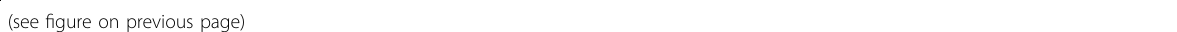
Fig. 2 Aspirin mediated protein deacetylation and autophagy induction in mouse leukocytes. a – c WT male mice (7 weeks old) received intraperitoneally (i.p.) injections of aspirin (100 mg/kg) and blood was collected at different time points (30, 60, 120, and 240 min post aspirin administration) ( b ), or mice were treated with different dose of aspirin (10, 100, or 300 mg/kg i.p. administration) and blood collected after 1 h ( c ), to determine the level of N ε lysine acetylation (representative image in ( a ), quanti fi cation in ( b , c ) ( n = 3/4 mice/group). d – g WT male mice were treated with aspirin (i.p. 100 mg/kg) and 6 h later, the level of N ε lysine acetylation (representative image in ( d ), quanti fi cation in ( e ) (Ctrl = 8 mice, aspirin = 7 mice) and autophagy induction, measured by counting the number of LC3B puncta per cell, in mice treated 2 h before the recovery of blood with leupeptin (i.p., 15 mg/kg), (representative image in ( f ), quanti fi cation in ( g )) ( n = 8 mice/group), were determined by immuno fl uorescence staining in the different leukocytes populations. h , i In the same experimental conditions described in ( d – g ), the autophagy associated level of LC3 lipidation was evaluated in the absence or presence of leupeptin (i.p., 15 mg/kg) administered 2 h before the recovery of blood (representative blots in ( h ), quantitation in ( I )) ( n = 3 mice/group, 2 independent experiments). In this fi gure, data are displayed as box and whisker plots, which show median, fi rst and third quartiles, and maximum and minimum values ( b , c , e , g ) or as scatter dot plot as mean ± s.e.m. i Circles, in the graphs, indicate each mouse used in the experiment. Statistical comparisons were done by one-way ANOVA ( b , c ), two-way ANOVA ( e , g ) and two-tailed unpaired Student ’ s t test ( i ) comparing aspirin-treated to untreated mice (* p < 0.05, ** p < 0.01, ** *p < 0.001). A.U arbitrary unit, Ctrl control, FC fold change, MFI mean fl uorescence intensity, min